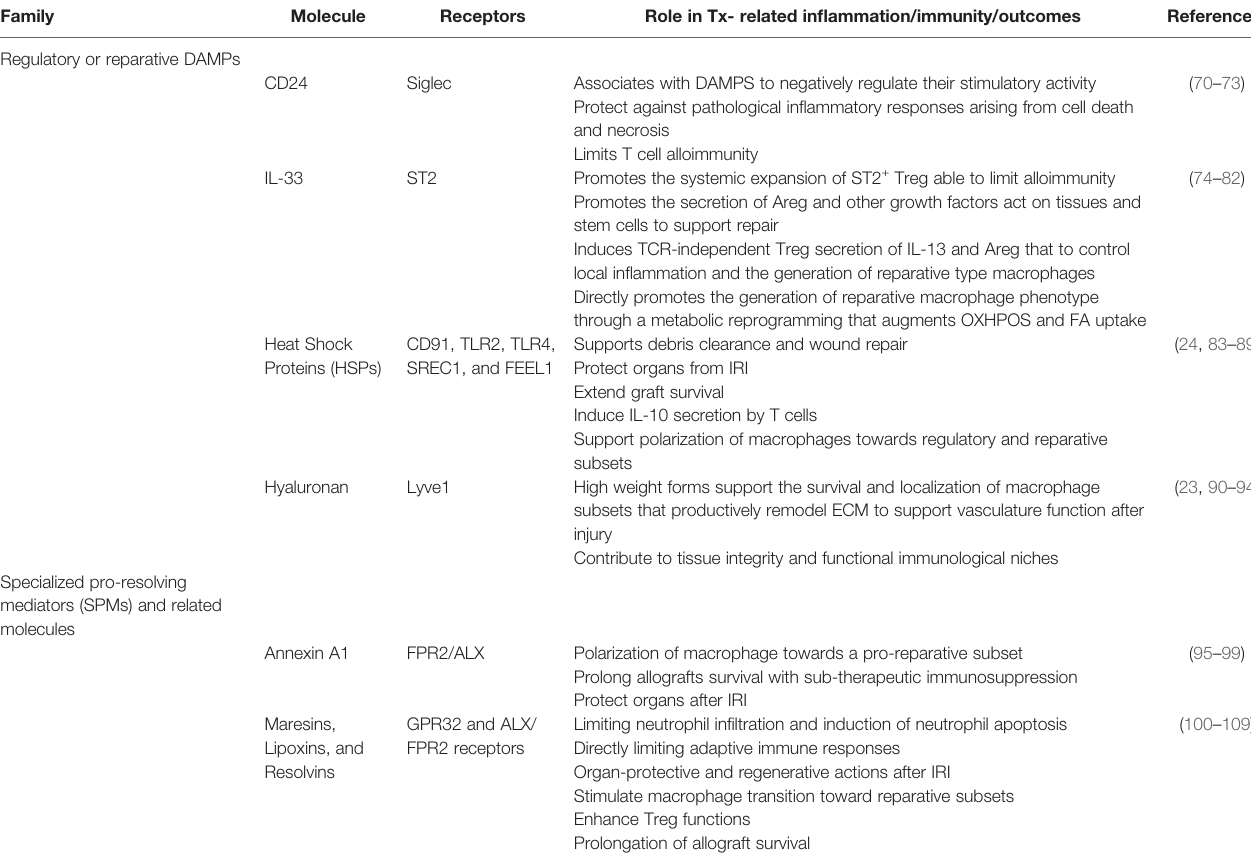
TABLE 2 | Regulatory or reparative DAMPs and related molecules in